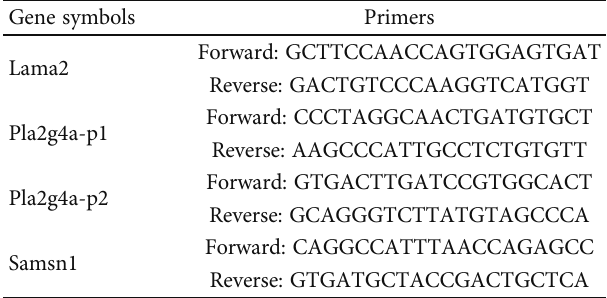
Table 1: The primer sequences used in the ChIP assay. Gene symbols